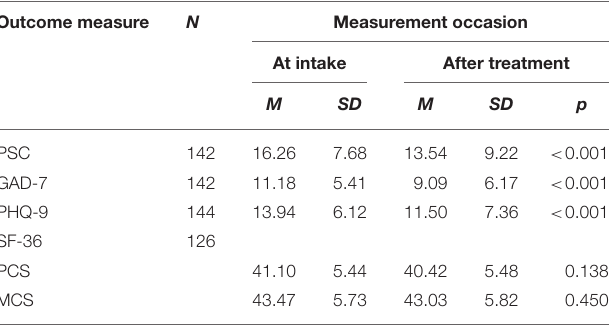
TABLE 2 | Mean scores on the PHQ-9, GAD-7, PSC, and SF-36 of the SSRD sample at intake and after treatment. Outcome measure